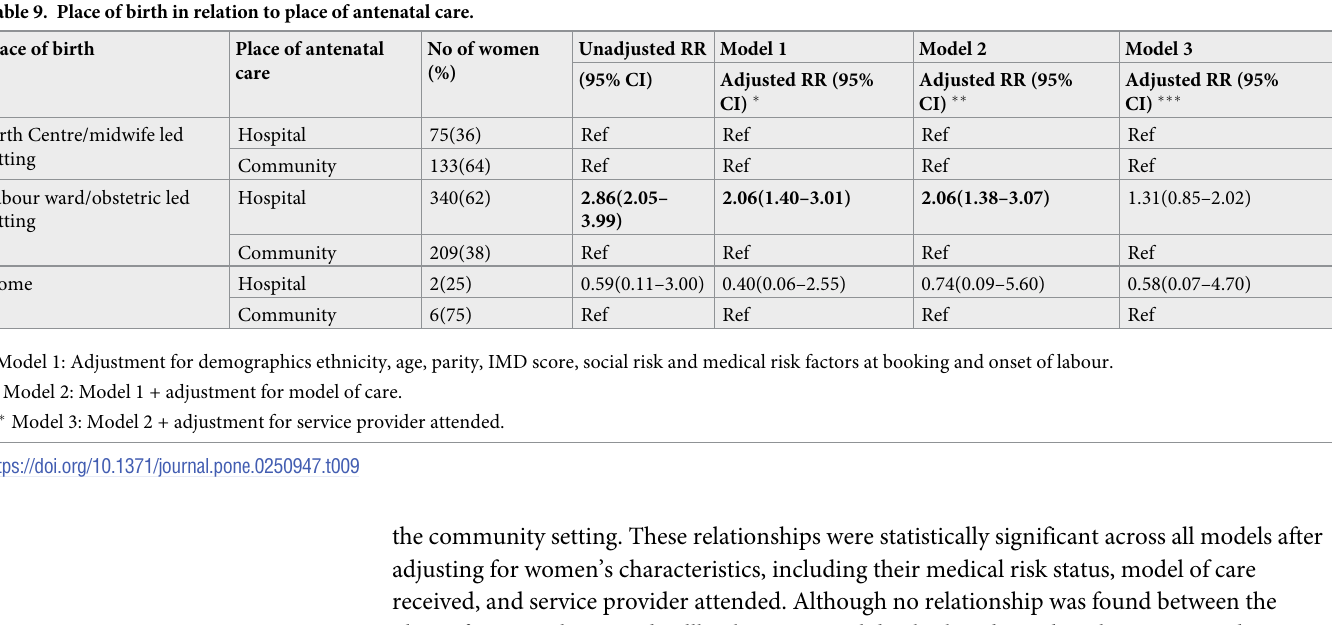
Table 9. Place of birth in relation to place of antenatal care.